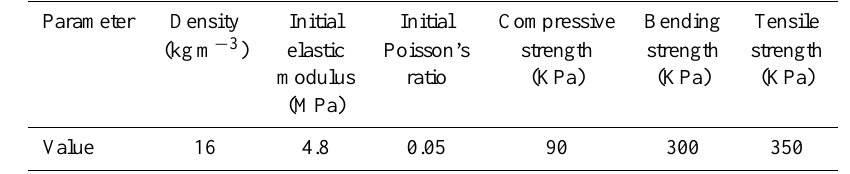
Table 1. Relevant parameters of EPS material.